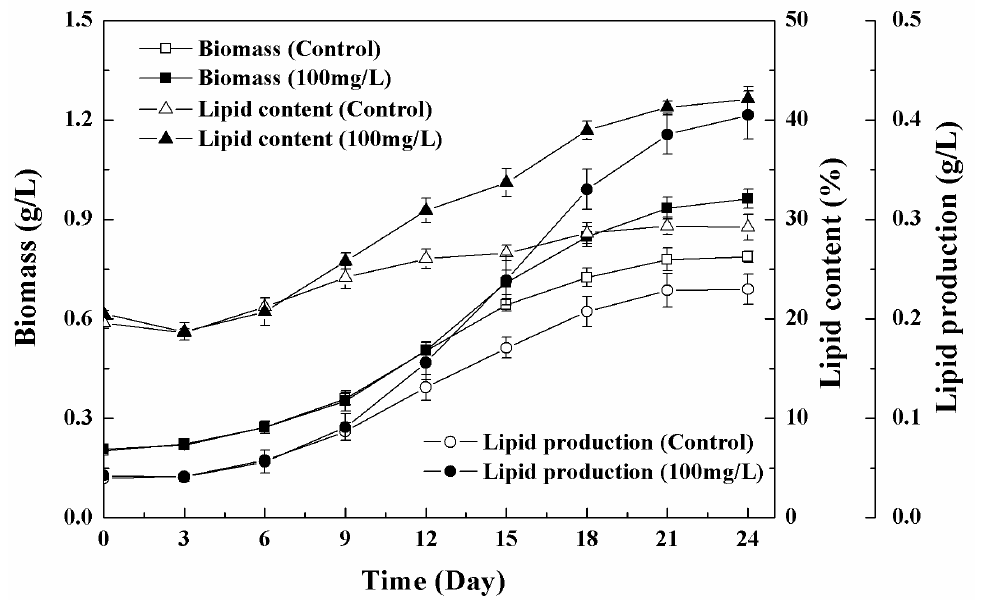
Figure 9. Change in biomass, total lipid content, and lipid production of Chlorella sp . UJ-3 exposed to 100 mg/L of Fe 3 O 4 NPs.